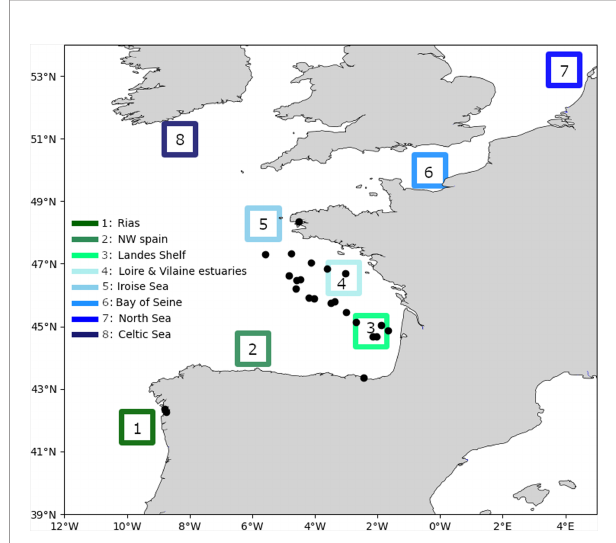
FIGURE 1 | Positions of the target areas de fi ned for the connectivities (boxes from 1 to 7) and in-situ samples. In-situ samples of the surface water (0-5m) were made in Ria de Vigo (July 2018), coastal Basque waters (2019 and 2020), Bay of Brest (May to July 2013, 2014 and 2015) and over the continental shelf (May 2018 and